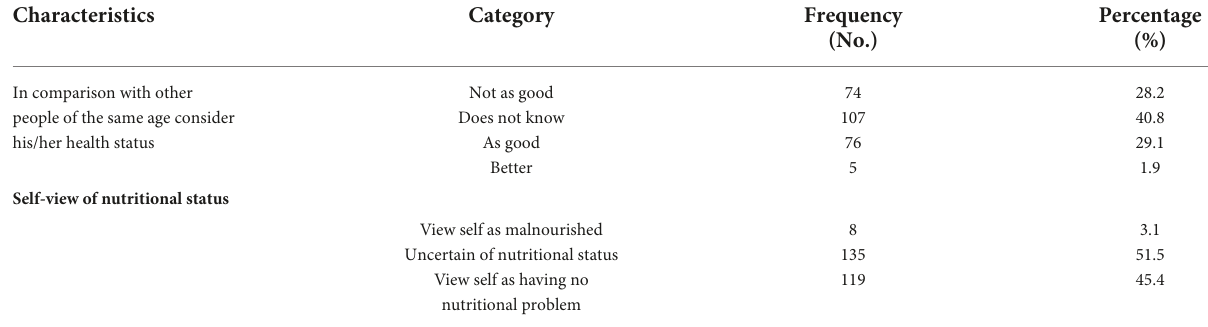
TABLE 7 Self-assessment of older adult patients with heart failure at Cardiac Clinic, University of Gondar hospital, June 01, 2021 to October 31, 2021 (No. 262). Characteristics